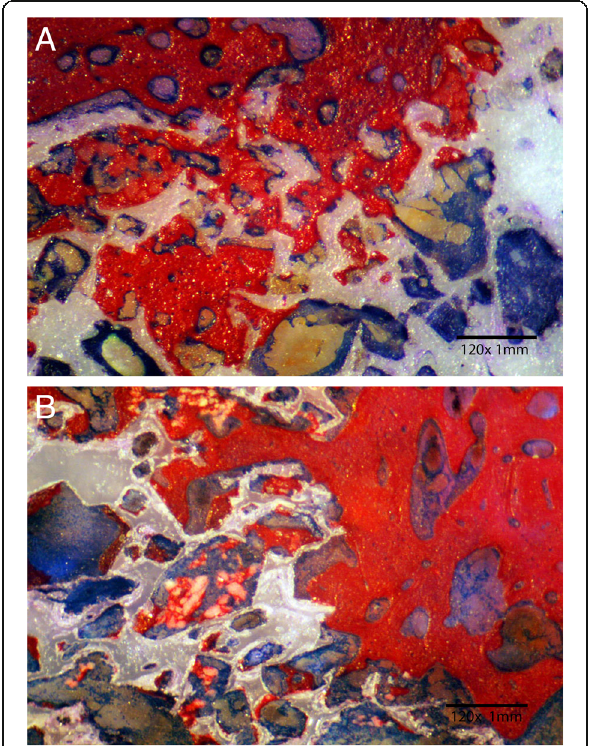
Fig. 2 a Histological section demonstrating new bone growth ( white arrow ) in HA-enriched zirconia scaffold ( black arrow ). Unmineralized bone stained blue. Almost entire surface porosity was filled with new dense bone. b Histological section demonstrating bone growth in HA-enriched zirconia scaffold starting from the periphery of the surgical wound ( white arrow ). Islands of entrapped HA particles were surrounded by mineralized boney matrix ( black arrow ) which were identified using